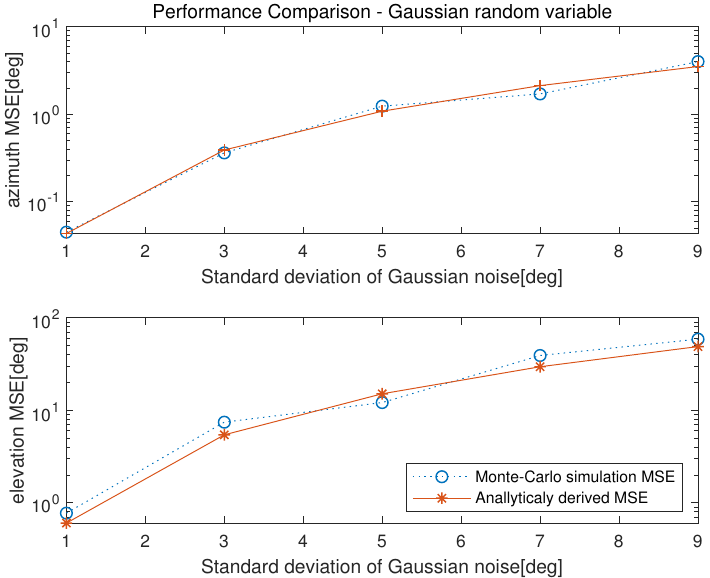
Figure 2. Performance for Gaussian − distributed phase measurement error with θ ( 0 ) = 120 ◦ and ψ ( 0 ) = 15 ◦ . This figure shows the mean square errors (MSEs) of azimuth and elevation with respect to phase error at a signal with low incident elevation. It can be confirmed that the MSE of elevation is larger than that of the azimuth at low elevation(uniform circular array).